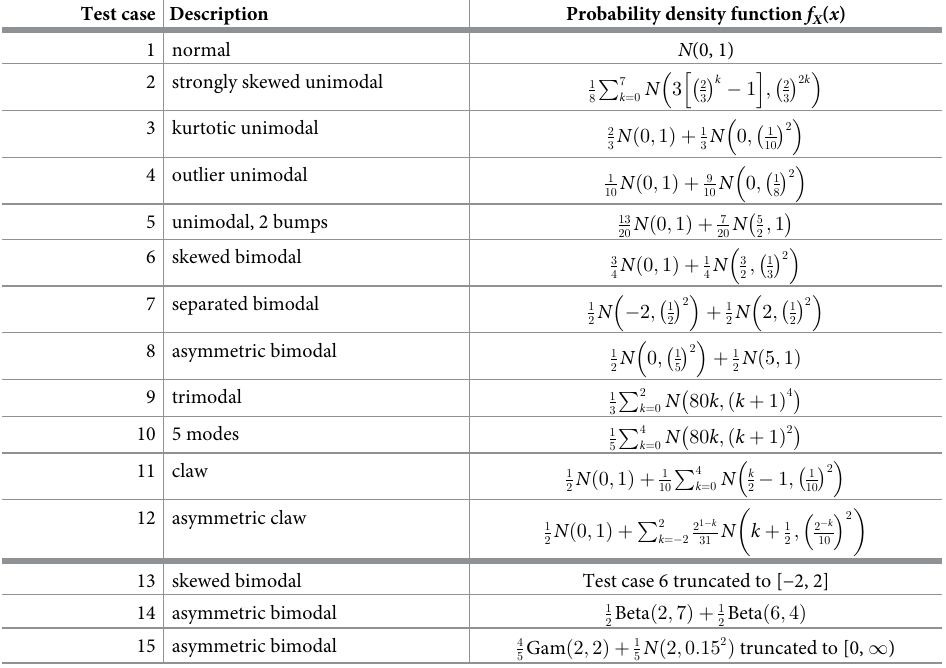
Table 3. Test cases of probability densities: Densities 1–12 are supported on ( − 1 , 1 ), density 13 on [ − 2, 2], den- sity 14 on [0, 1] and density 15 on [0, 1 ). N ( μ , σ 2 ) denotes the normal density with mean μ and standard deviation σ , Beta( α , β ) denotes the beta density with shape parameters α and β , and Gam( α , β ) denotes the gamma density with shape parameter α and rate parameter β . Test case